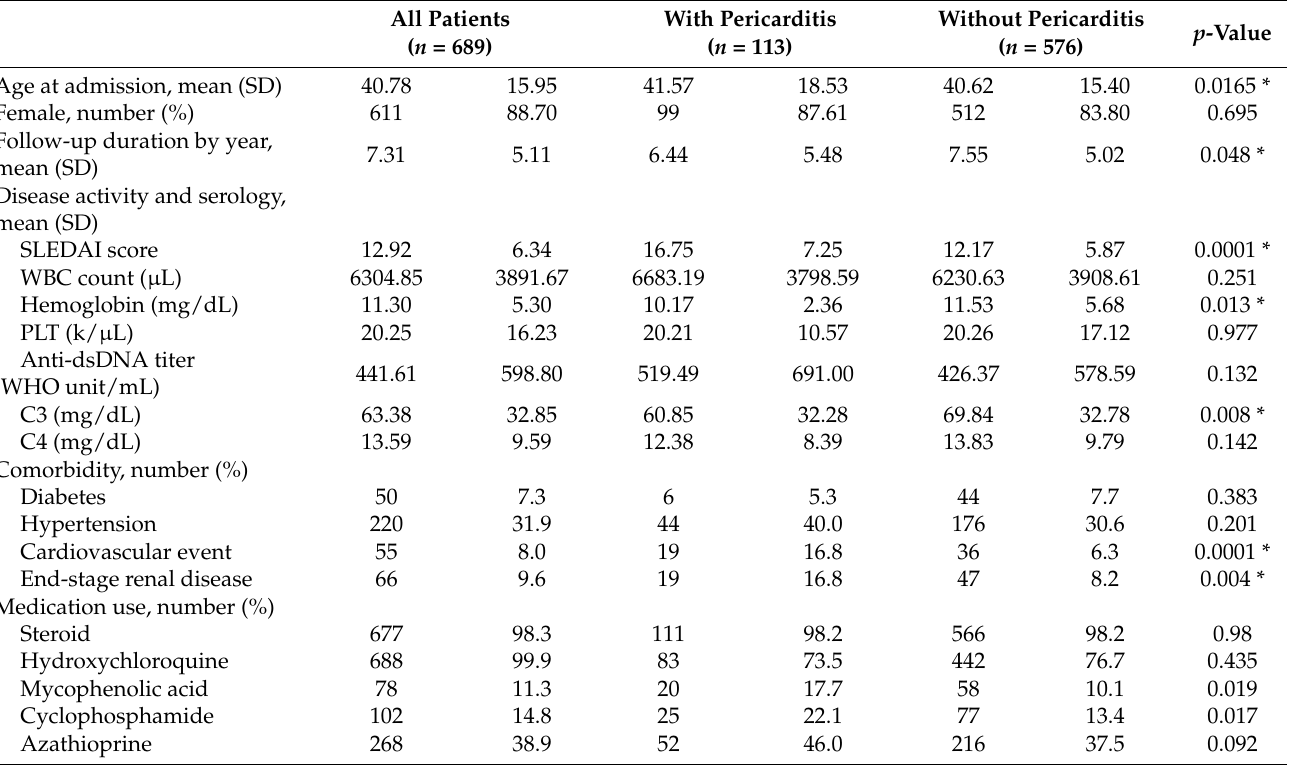
Table 1. Baseline characteristics of SLE patients with and without lupus